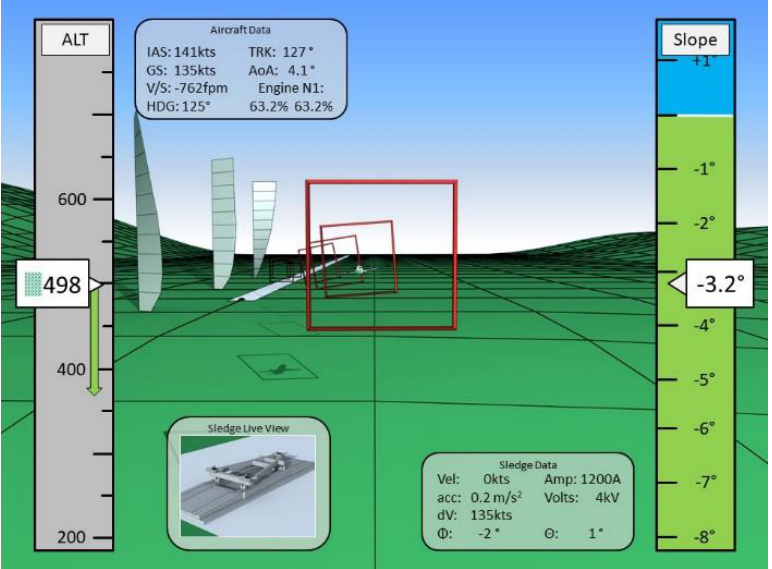
Figure 2. Development of cockpit tools to support precision landing.